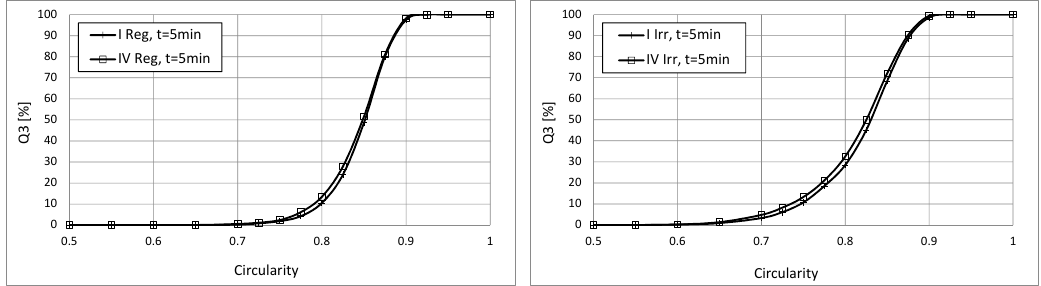
Figure 18. Distributions of convexity index for enrichment products I and IV for regular and irregular particles.